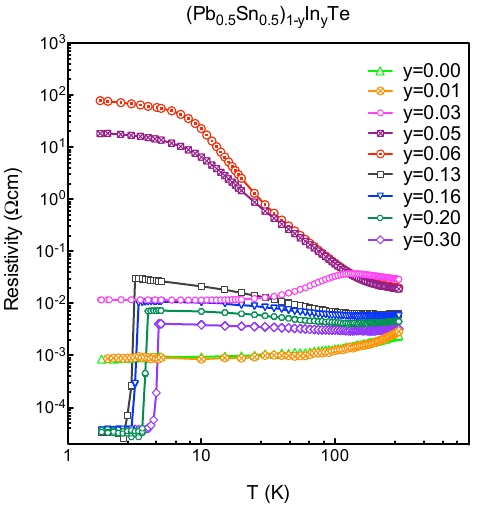
Figure 2. Temperature dependence of the resistivity for (Pb 0.5 Sn 0.5 ) 1 − y In y Te single crystals with indium contents 0 ≤ y ≤